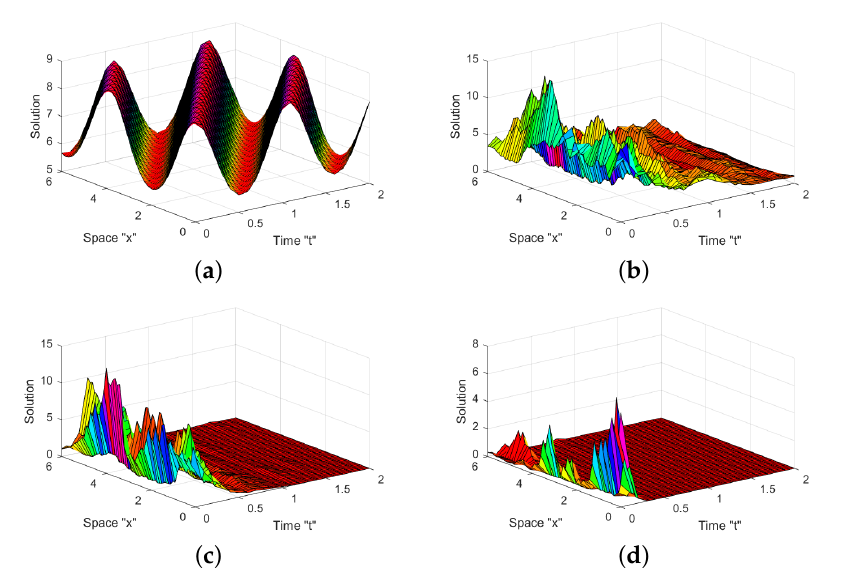
Figure 1. For Equation (33), ( a – d ) with k = − 1, α = 1, β = 0, λ = − 4, indicate the 3D profiles ( a ) σ = 0 ( b ) σ = 0.5 ( c ) σ = 1 and ( d ) σ =